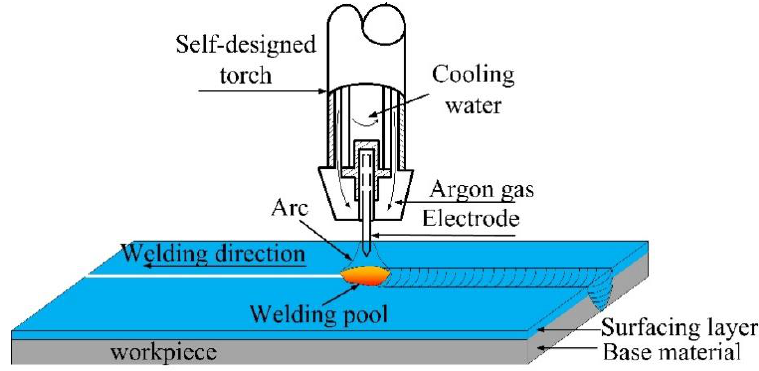
Figure 2. Diagram of the K-TIG welding process.